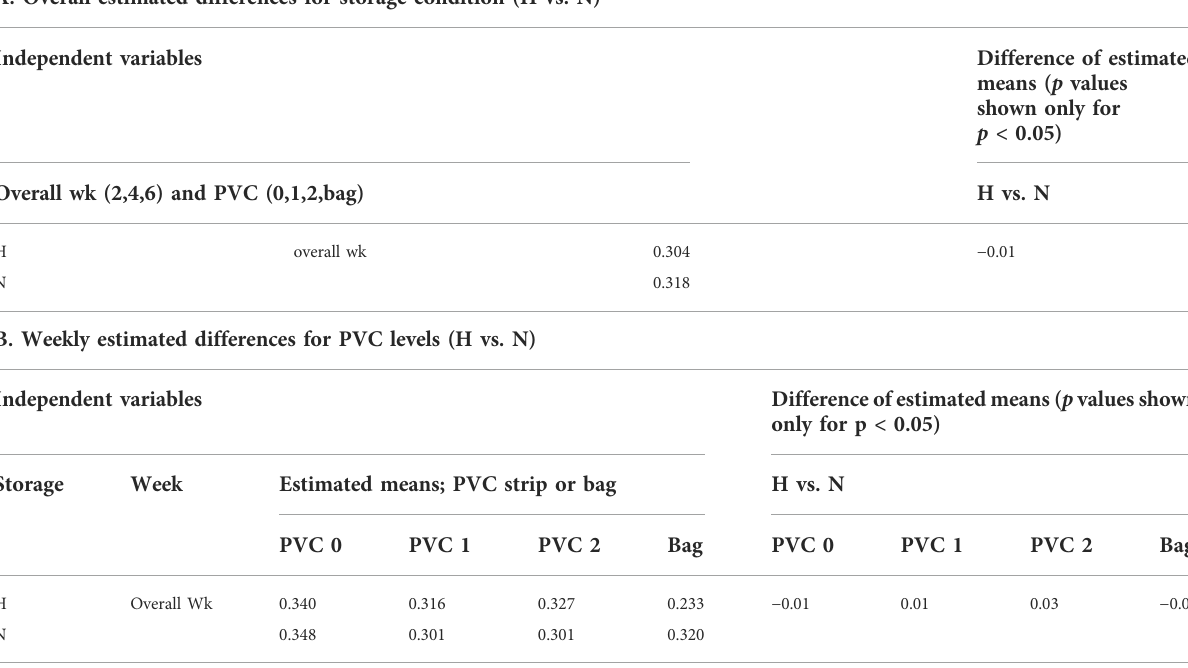
TABLE 2 Hemolysis: Mean estimated values from the model. A. Overall estimated differences for storage condition (H vs. N) Independent variables Difference of estimated